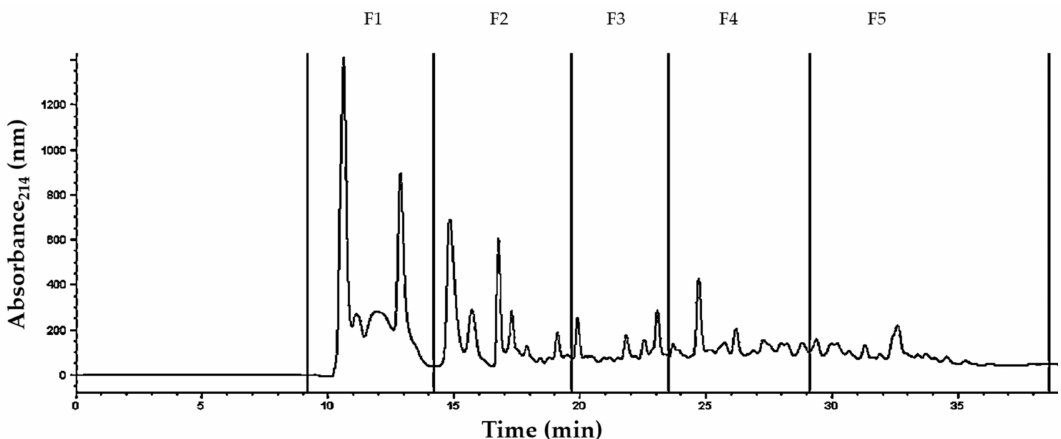
Figure 7. Peptide profiles in the water soluble fraction (<10 kDa) from pasteurized fermented milk (PFM10) with Lactobacillus fermentum J28, obtained by reversed-phase High Performance Liquid Chromatography at 214 nm. F1 to F5 correspond to collected fractions.